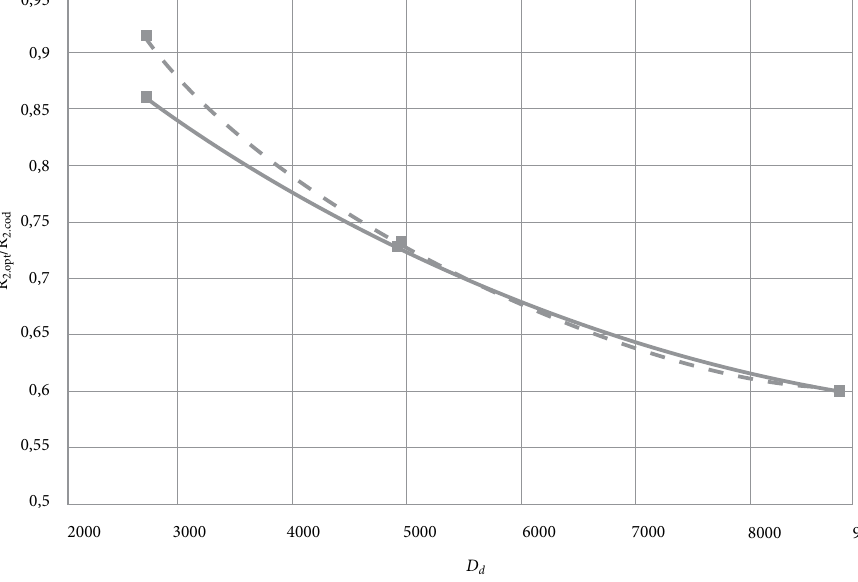
fig. 5. Dependence of relation R 2.opt /R 2.cod from D d